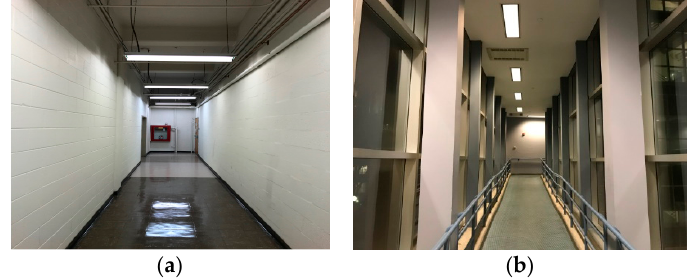
Figure 3. An example of a scene in which its features have completely changed during renovation. ( a ) Image captured before renovation (reference image); ( b ) Image captured after renovation (current image).